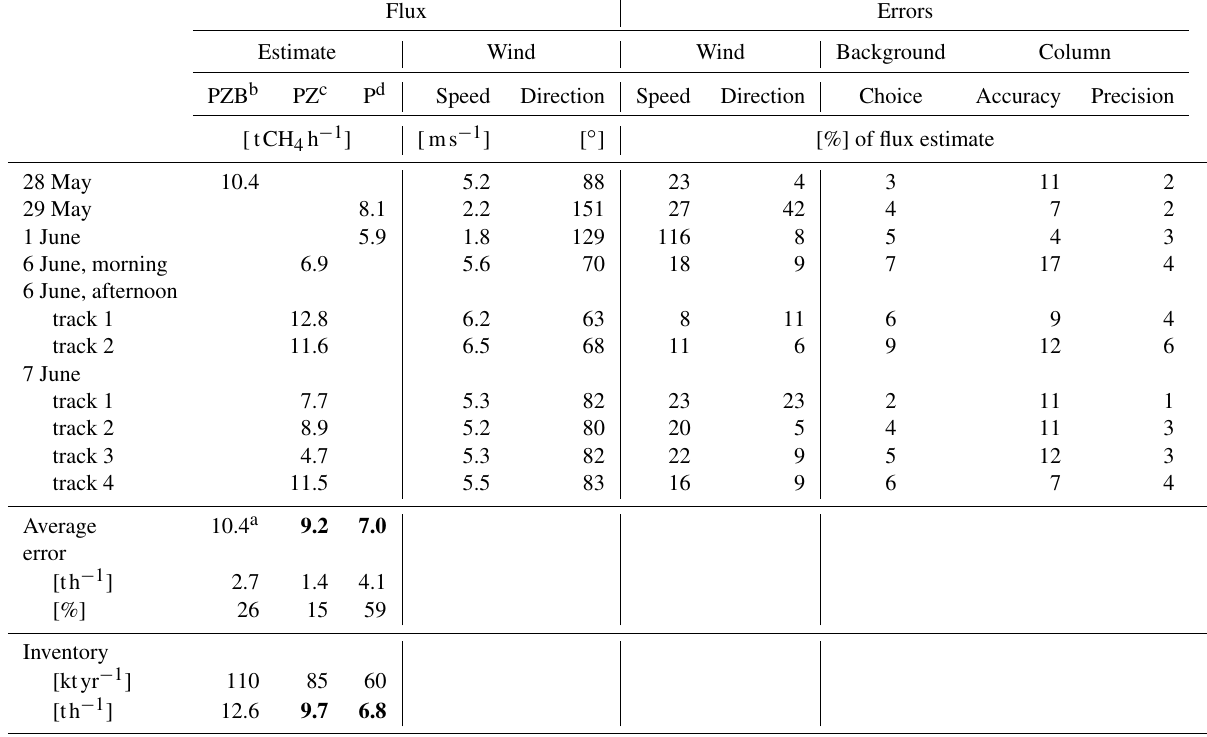
Table 2. Cross-sectional flux estimates for shaft cluster b located in the south-western part of the basin during six different flights and the corresponding winds as derived from the three wind lidar stations (left part). The right part gives the errors of the five components (in %) of the computed flux. The footnote states which mines (number in brackets gives the number of shafts) were investigated. The stated errors of the mean flux (if more than one overflight was available) comprise the uncertainty from the error propagation of the cross-sectional flux method and the track-to-track variability (or atmospheric turbulence) according to Eq. (A4) as discussed in Sect. A2. The last two rows give the annual [ktyr − 1 ] and annually scaled emissions to 1h [th − 1 ] of 2018 based on the CoMet ED v4 inventory (Table 1) for comparison with the observed averaged fluxes. For certain shafts, real hourly emissions are available and discussed in Sect.